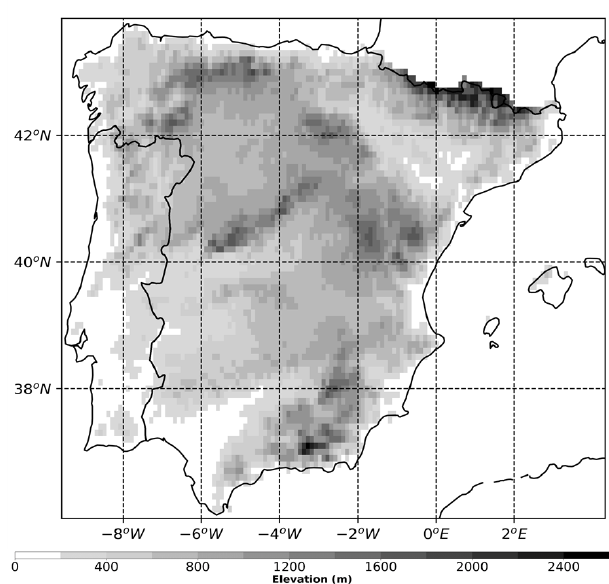
Figure 1. Orography from the Iberian Gridded Dataset for the Iberian Peninsula at 0.1 ◦ horizontal